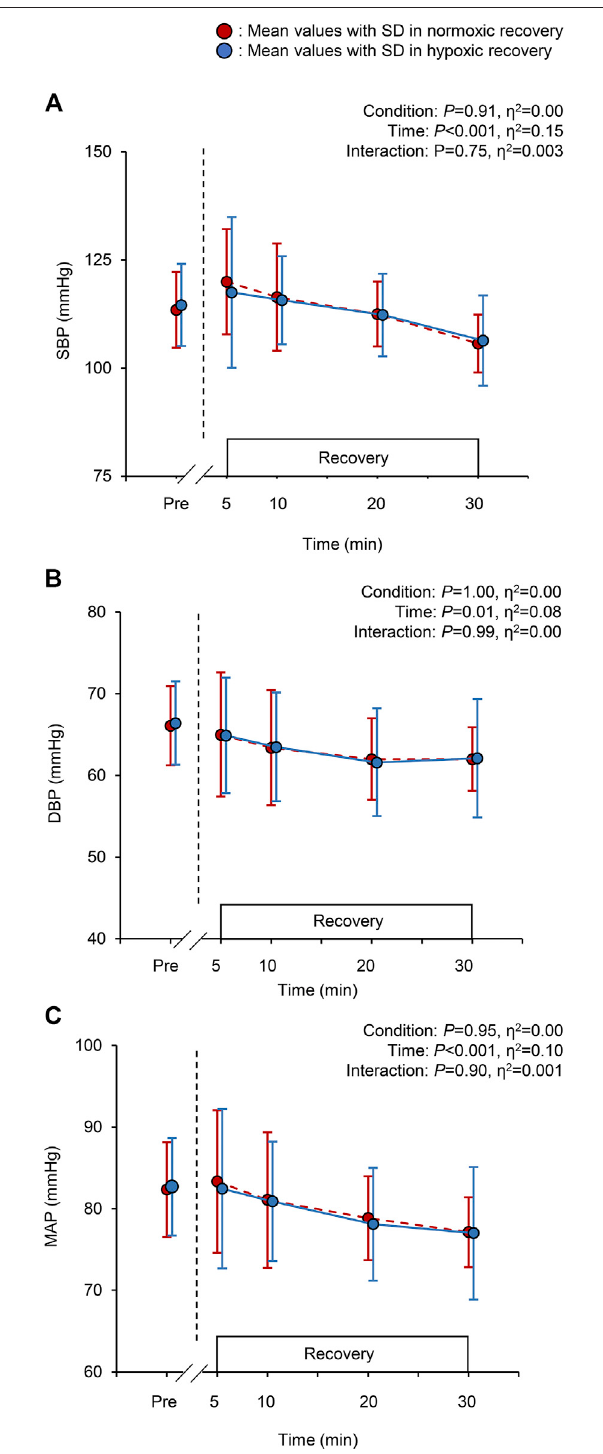
FIGURE 2 | Changes in the systolic blood pressure [SBP; panel (A) ], diastolic blood pressure [DBP; panel (B) ], and mean arterial pressure [MAP; panel (C) ] at baseline (pre) and during the 30-min recovery under normoxia andhypoxia.Valuesarethemean±standarddeviation(SD).Theredand blue circles indicate normoxic and hypoxic recovery conditions, respectively.